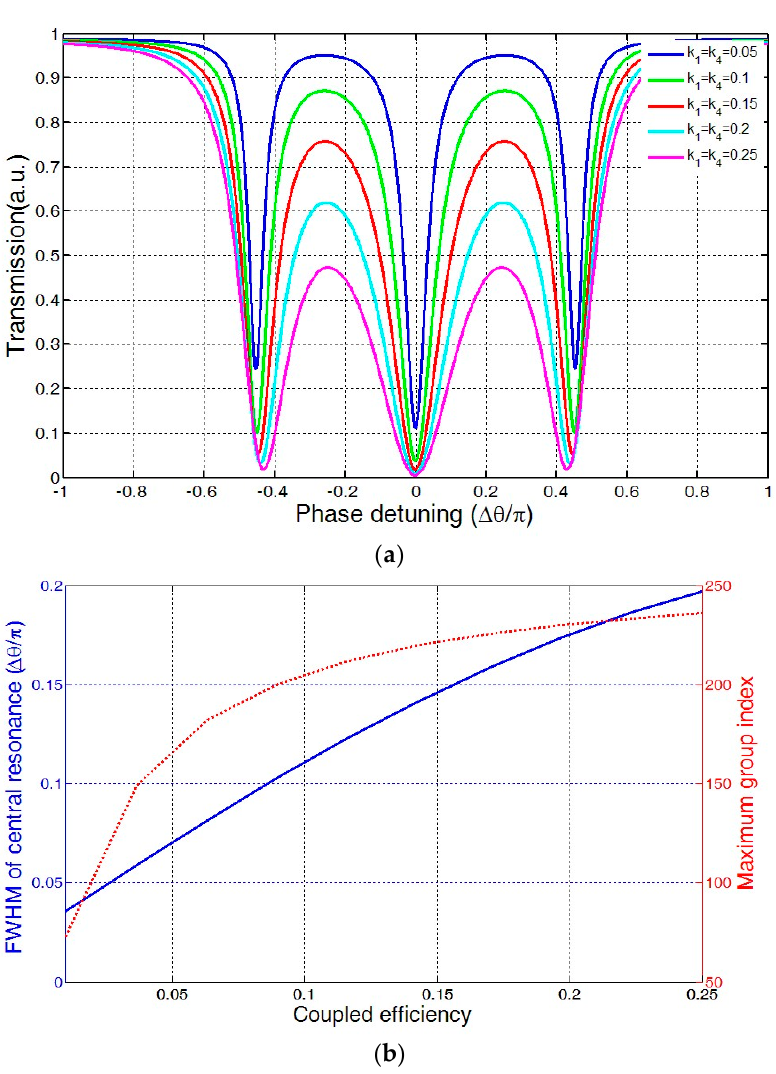
Figure 2. Effect of waveguide-microring coupling coefficient: ( a ) on transmission spectrum ( b ) on FWHM (full width at half maximum) of central resonance and maximum group index.